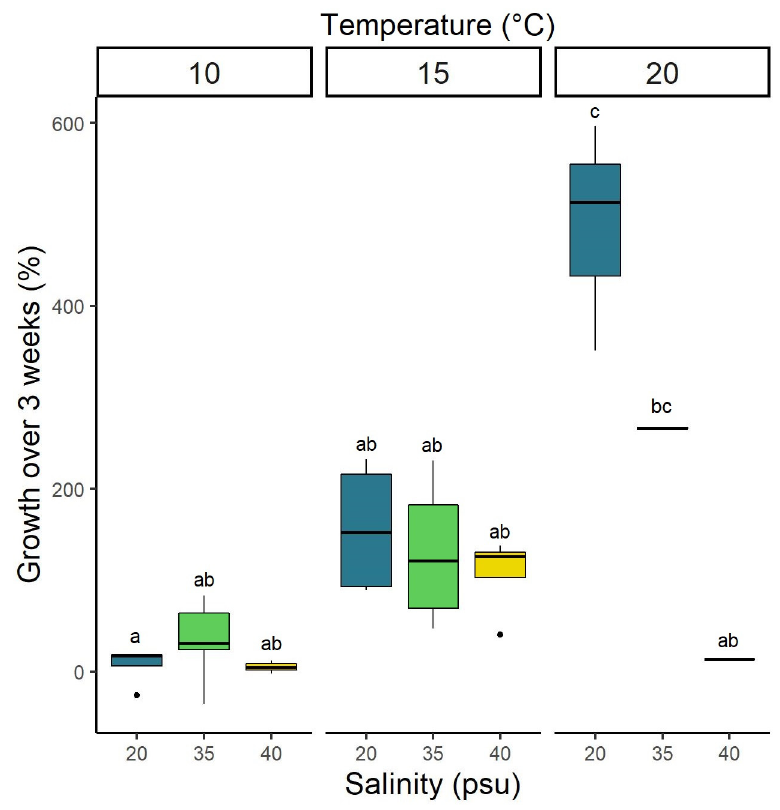
Figure 7. Growth (in %) of Aurelia solida ephyrae that were kept at twelve different combinations of temperatures and salinities over 21 days of the experiment ( n = 9 per combination). Values are presented as boxplots including quartiles (box and whiskers), median (horizontal line), and outliers (points). Letters above the boxplots indicate groups identified by Tukey’s HSD post-hoc test.